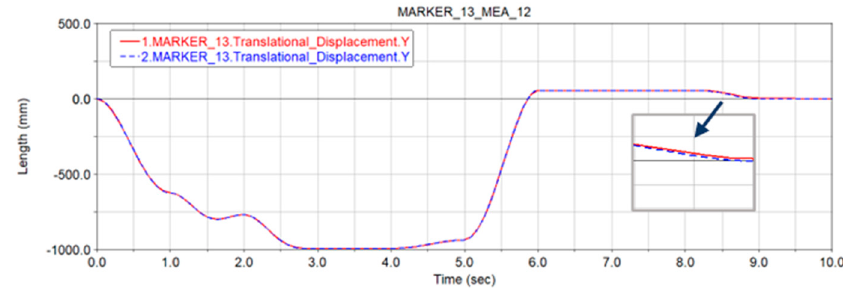
Figure 13. Comparison of simulation displacement curves in the y ‐ direction.